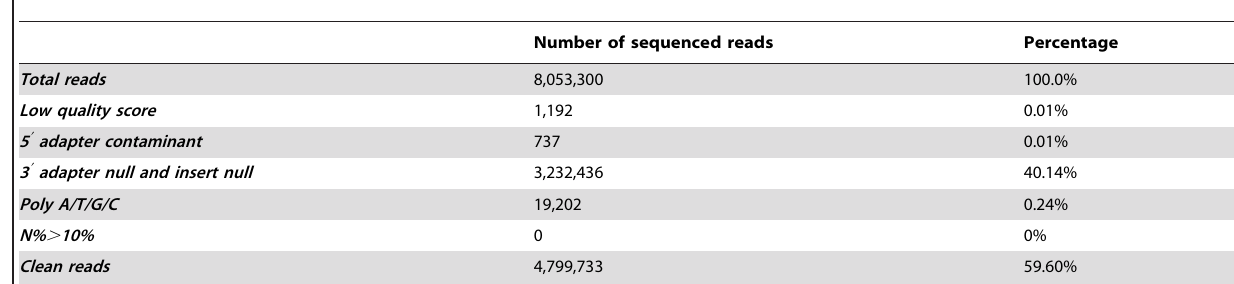
Table 1. Summary of the small RNA transcriptome sequencing of the A. japonicus tube